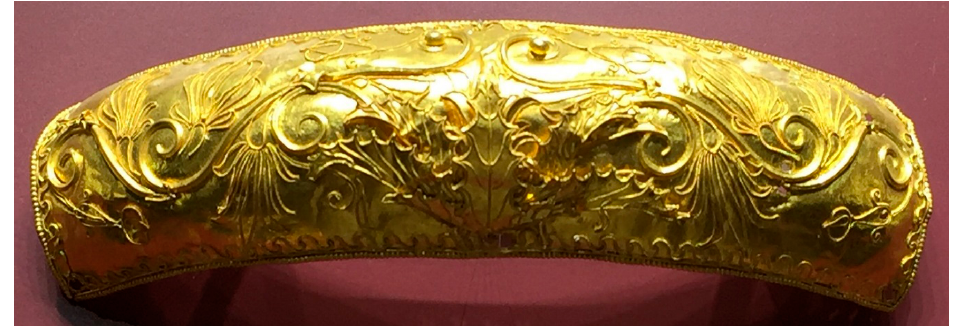
Figure 7. Paestum, Museo Archeologico Nazionale Floral thymiaterion base from the southern urban